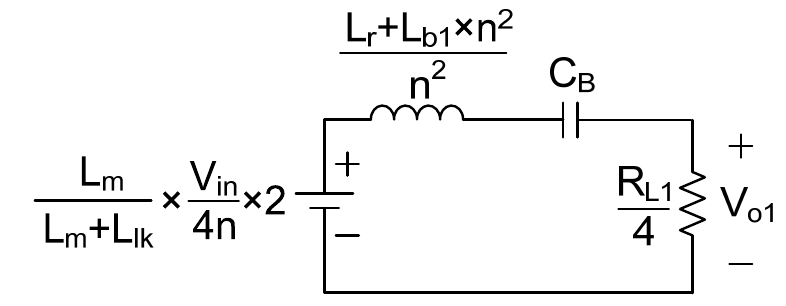
Figure 19. Simplified equivalent circuit of secondary side